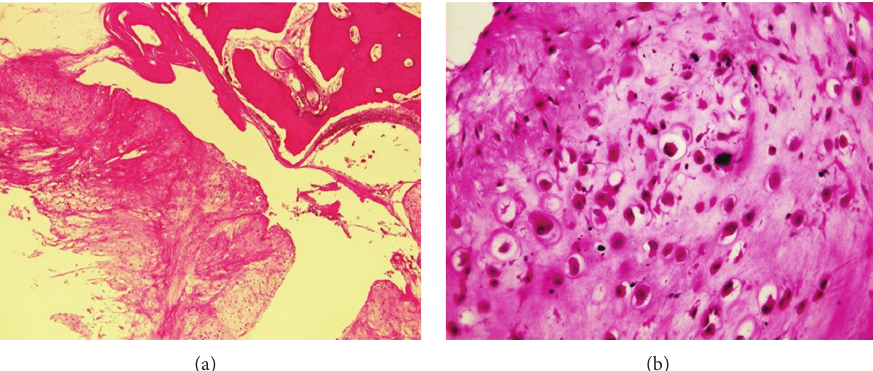
Figure 4: (a) Atypical chondrocytic cells in myxoid or chondroid matrix showing scattered granular calcified materials ( × 40, HE staining) and (b) pleomorphism with bizarre appearance of nuclei ( × 400, HE staining).